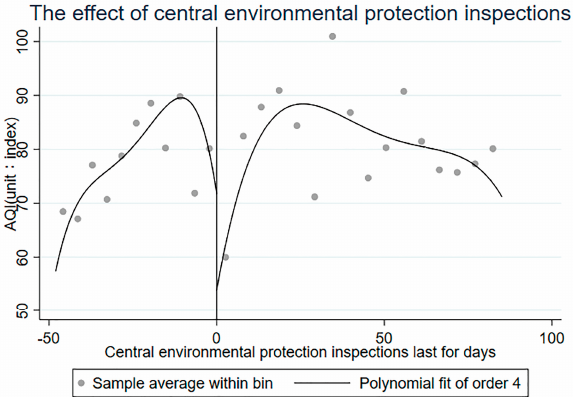
Figure 4. Contaminant concentration: order-4 polynomial fitting curve.